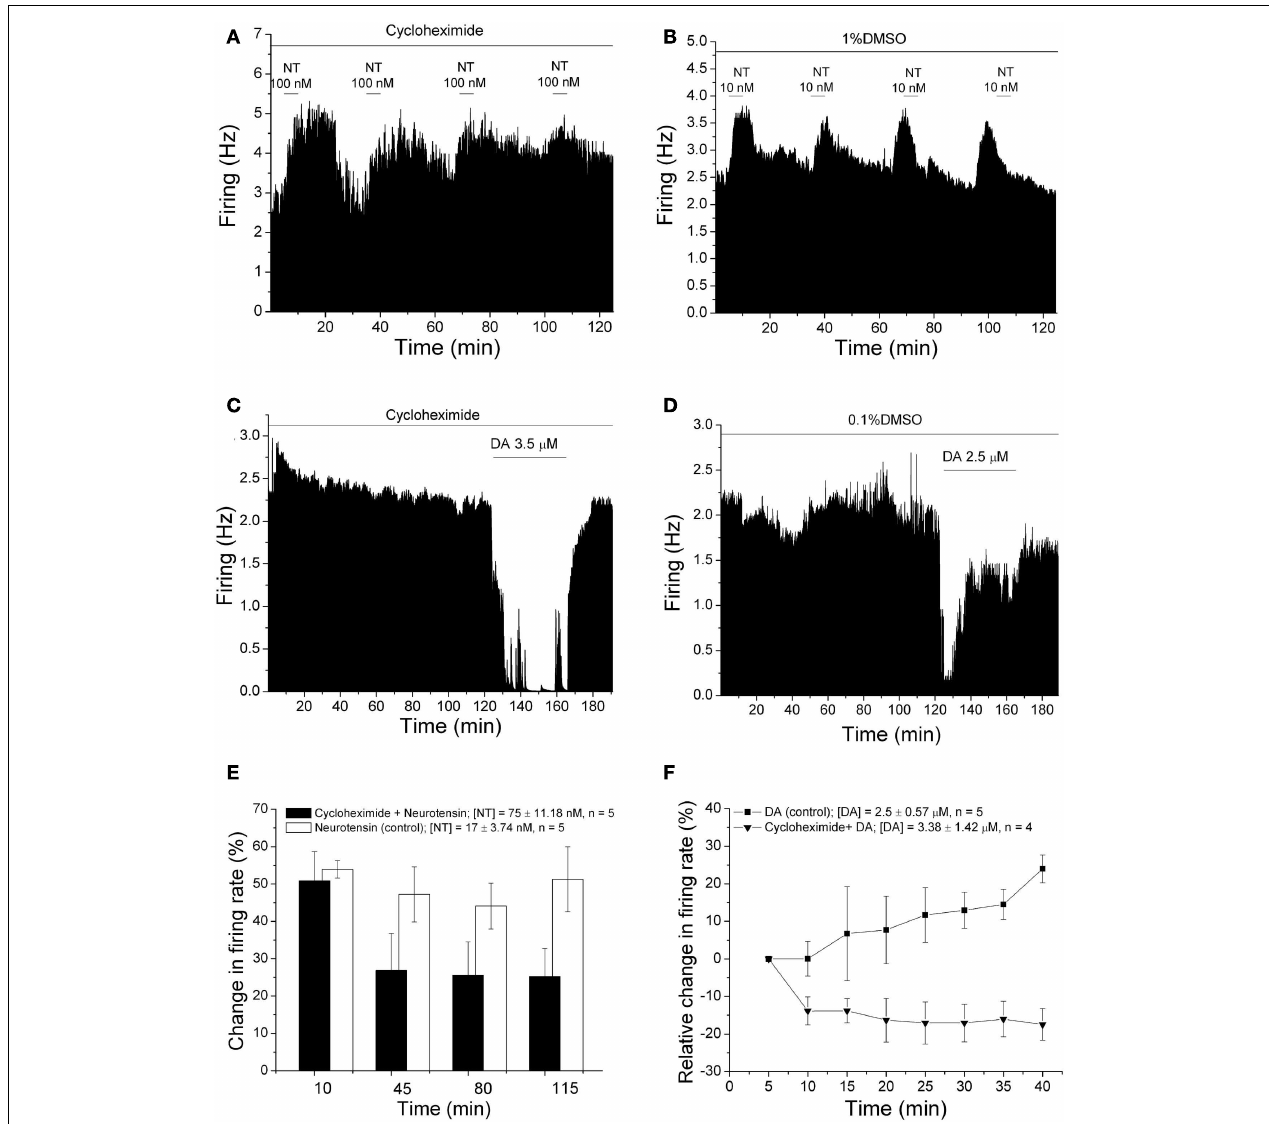
reversal of dopamine-induced inhibition was observed when cycloheximide was included in the micropipette. (E) Bars representing the mean responses to neurotensin in recordings similar to those shown in (A,B) . Mean excitatory effect of neurotensin is shown at each time period for cells recorded with micropipettes to which cycloheximide (filled bars) or vehicle (open bars) was added.There was a significant reduction in the excitatory effect of neurotensin in recordings in which cycloheximide was present in the micropipettes. (F) Relative change in firing rate (mean ± SEM) is plotted as a function of time. In experiments similar to those shown in (C,D) above, the effect of dopamine [after 2h application of either cycloheximide ( (cid:72) ) or vehicle ( (cid:4) )] at each time point was normalized by subtracting the change in firing rate (%) at the 5-min time point. No reversal of dopamine-induced inhibition was observed when cycloheximide was present in the micropipettes.